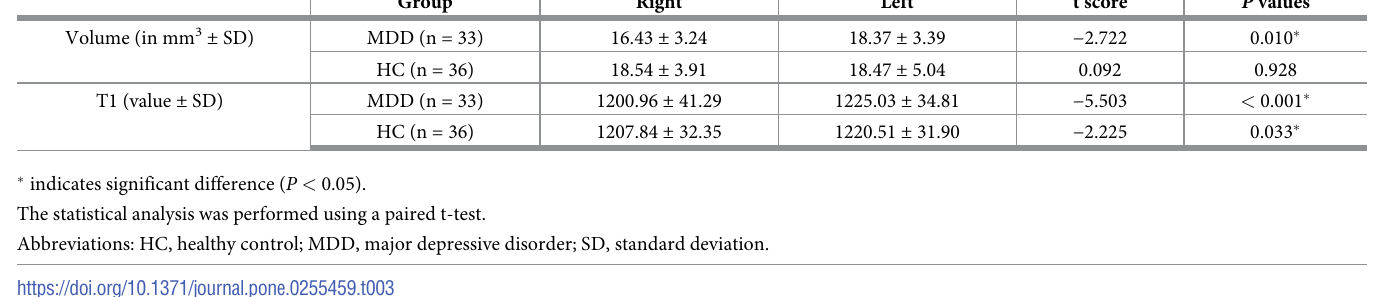
Table 3. Comparison of the volume and T1 value between right and left habenula segmented by both examiners between each group. Group